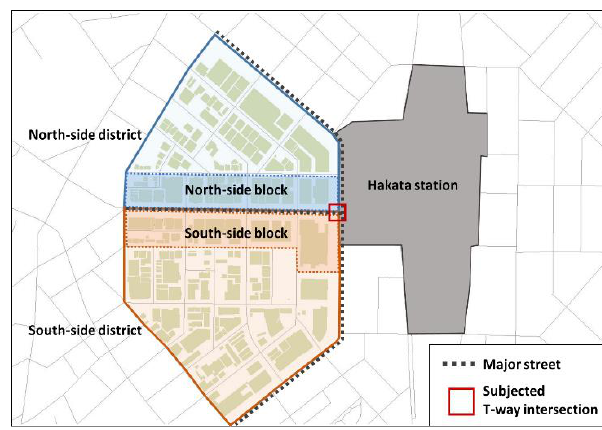
Figure 3. The sub-areas of the urban area in front of Hakata station which are separated into the North-side district, South- side district, North-side block, and South-side block.